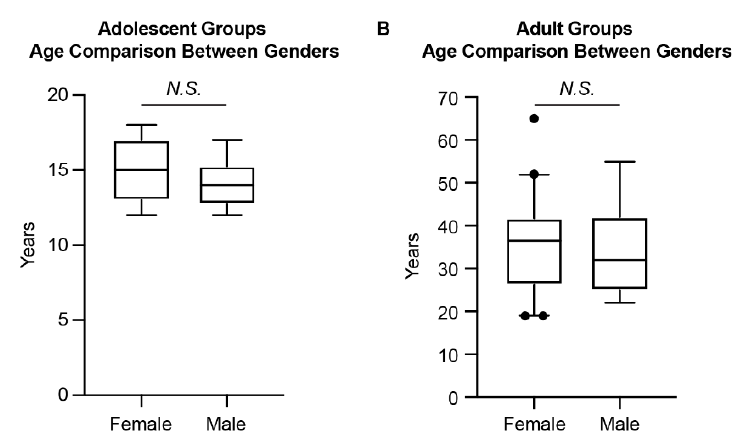
Figure 2. The age comparison between genders for the adolescent and adult groups. ( A ) The age comparison for the adolescent groups. ( B ) The age comparison for the adult groups. The Mann– Whitney U test was used. The box plot represents the 5th percentile, 25th percentile, median (50th percentile), 75th percentile, and 95th percentile, respectively. N.S . : not significant.